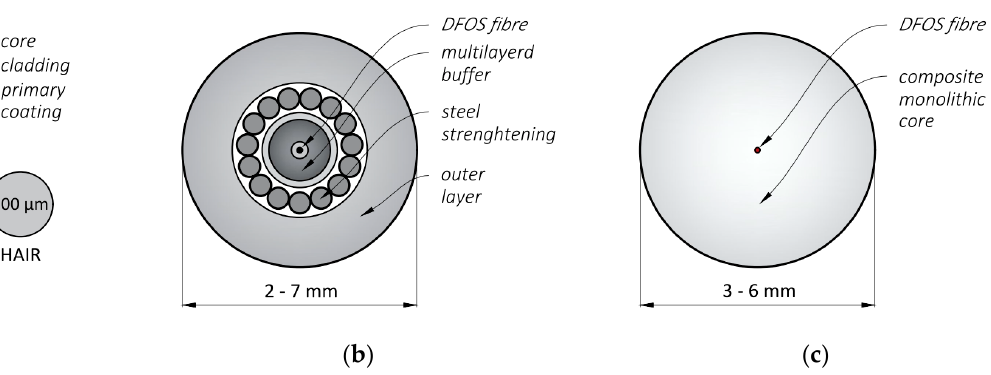
Figure 7. Example cross-sections of ( a ) single-mode optical fibre in its primary coating, ( b ) layered sensing cable with steel strengthening insert, and ( c ) monolithic strain sensor.